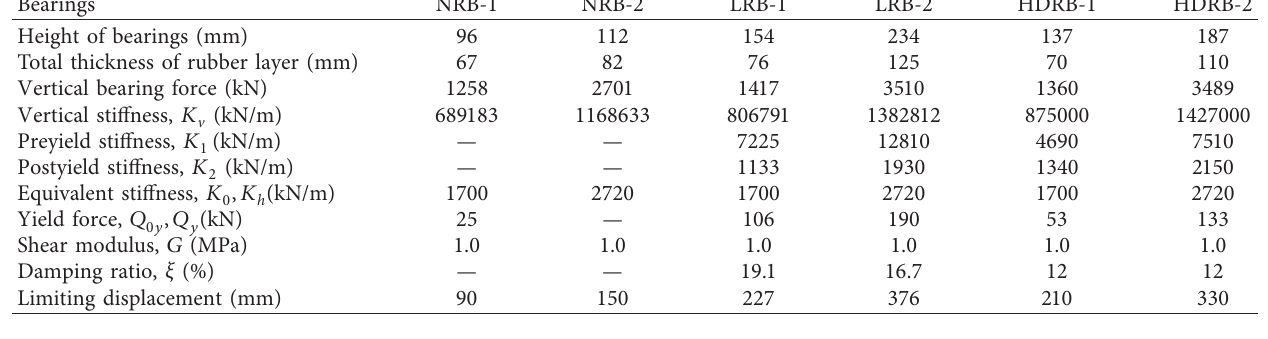
Table 2: Physical parameters of bearings.